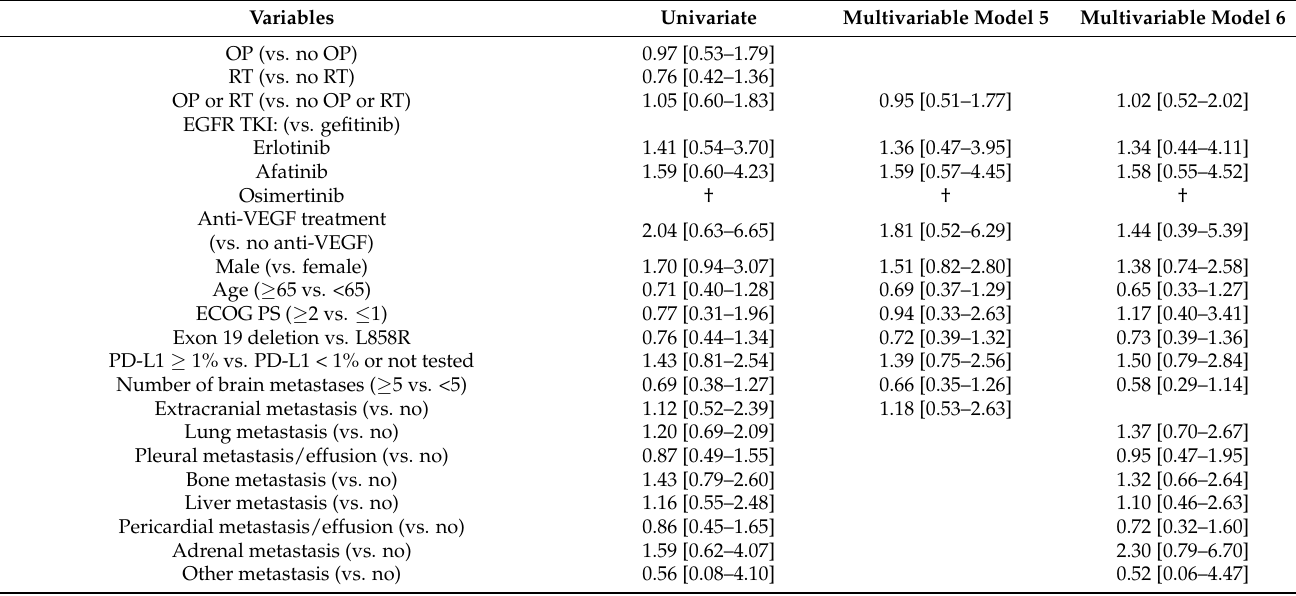
Table A4. Factors associated with intracranial progression-free